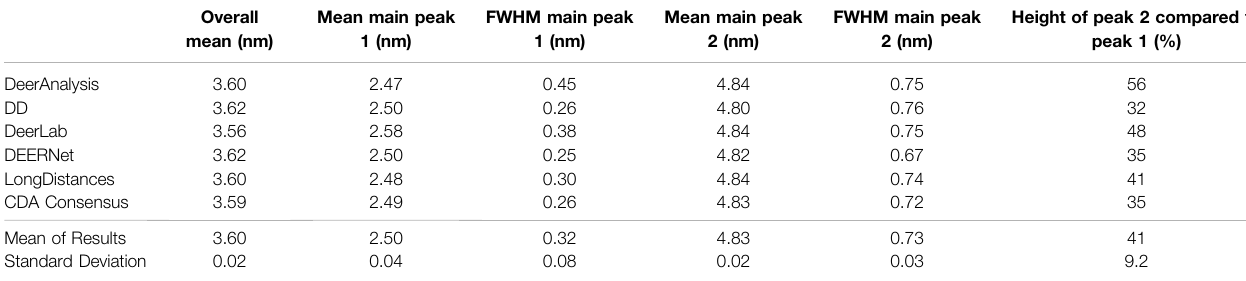
TABLE 5 | Results from each program for the simulated DEER-with-noise data